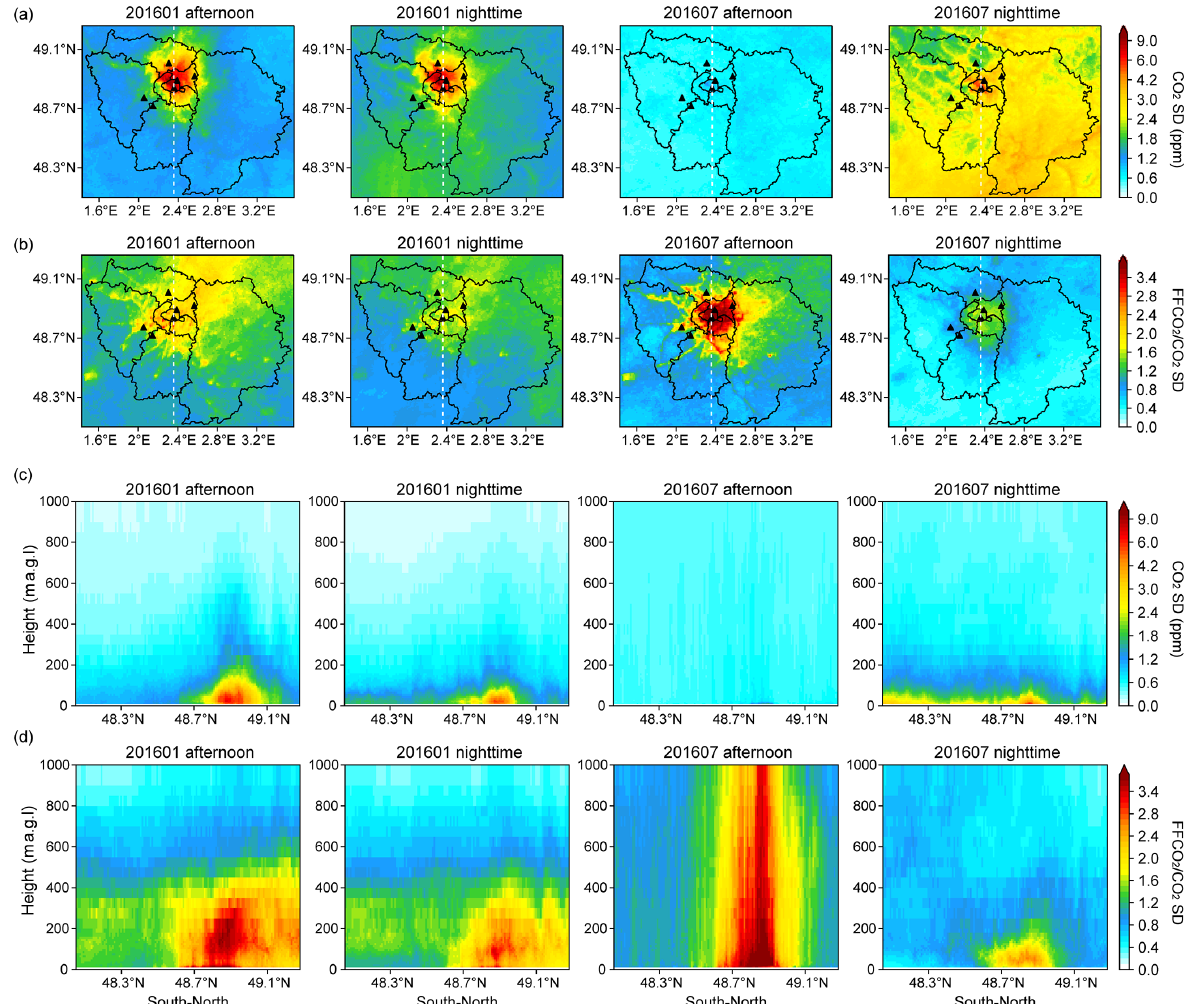
Figure 11. Analysis of the signal-to-noise ratio as discussed in the text for two periods of the day (afternoon 11:00–16:00UTC, nighttime 00:00–05:00UTC), and 2 months (January, July 2016). Panel (a) is the median of the hourly standard deviation of the simulated near-surface CO 2 concentration computed among the five sensitivity runs (Table 1a); panel (c) is the same as panel (a) but for a vertical south–north slice that goes through the JUS station (shown as white dash lines); panel (b) is the median ratios of the hourly anthropogenic CO 2 concentration (average of the five sensitivity runs) to its respective standard deviation of the total CO 2 concentrations among the five sensitivity runs; panel (d) is the same as panel (b) but for the same vertical slice as in panel (c)